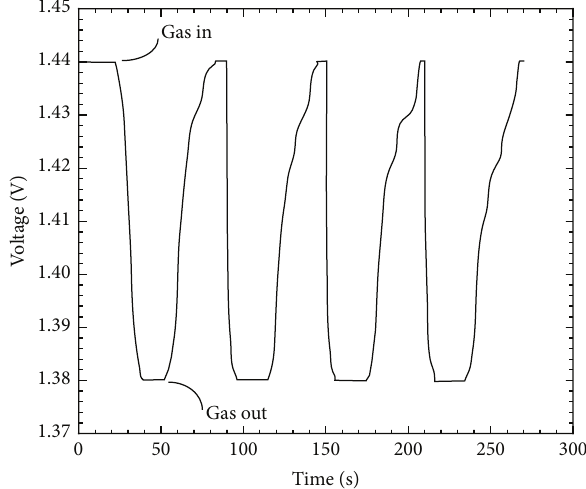
Figure 5: The on/off response profile of sensor based on BCG- PEDOT:PSS to ammonia